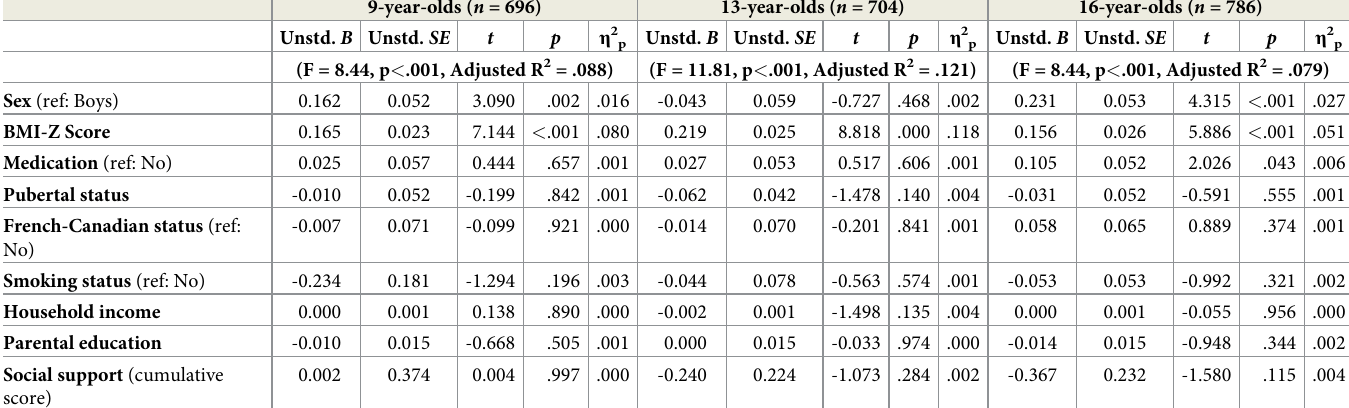
Table 4. Prediction model by